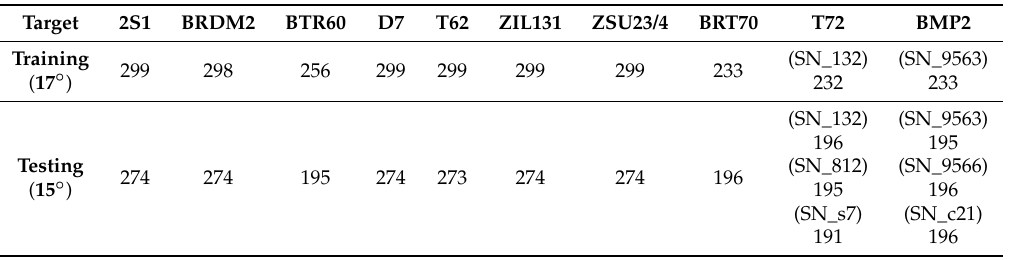
Table 1. The number of images for training and testing about the ten targets under standard operating conditions